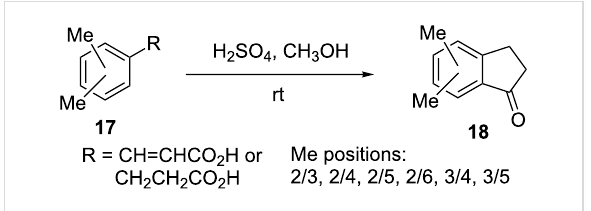
Scheme 7: Synthesis of 1-indanones 18 from arylpropionic and 3-arylacrylic acids 17